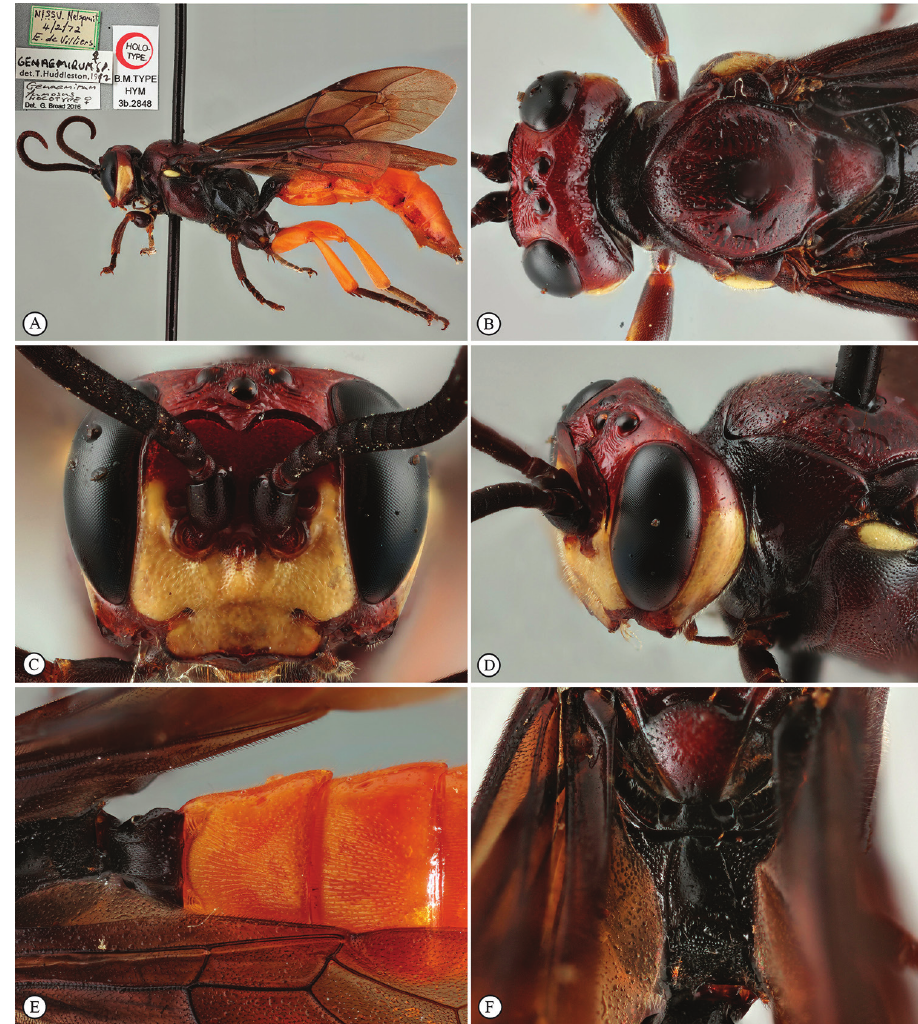
Figure 4. Genaemirum fumosum sp. n. Holotype female. A habitus lateral view (inset: data labels) B head, mesosoma, dorsal view C head anterior view D head, mesosoma anterior-lateral view E metasomal tergites 1-4 dorsal view F propodeum, dorsal